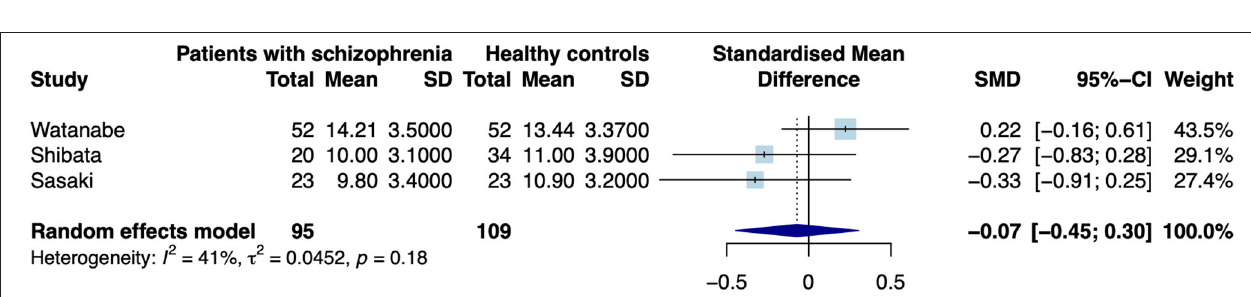
Frontiers in Psychiatry |